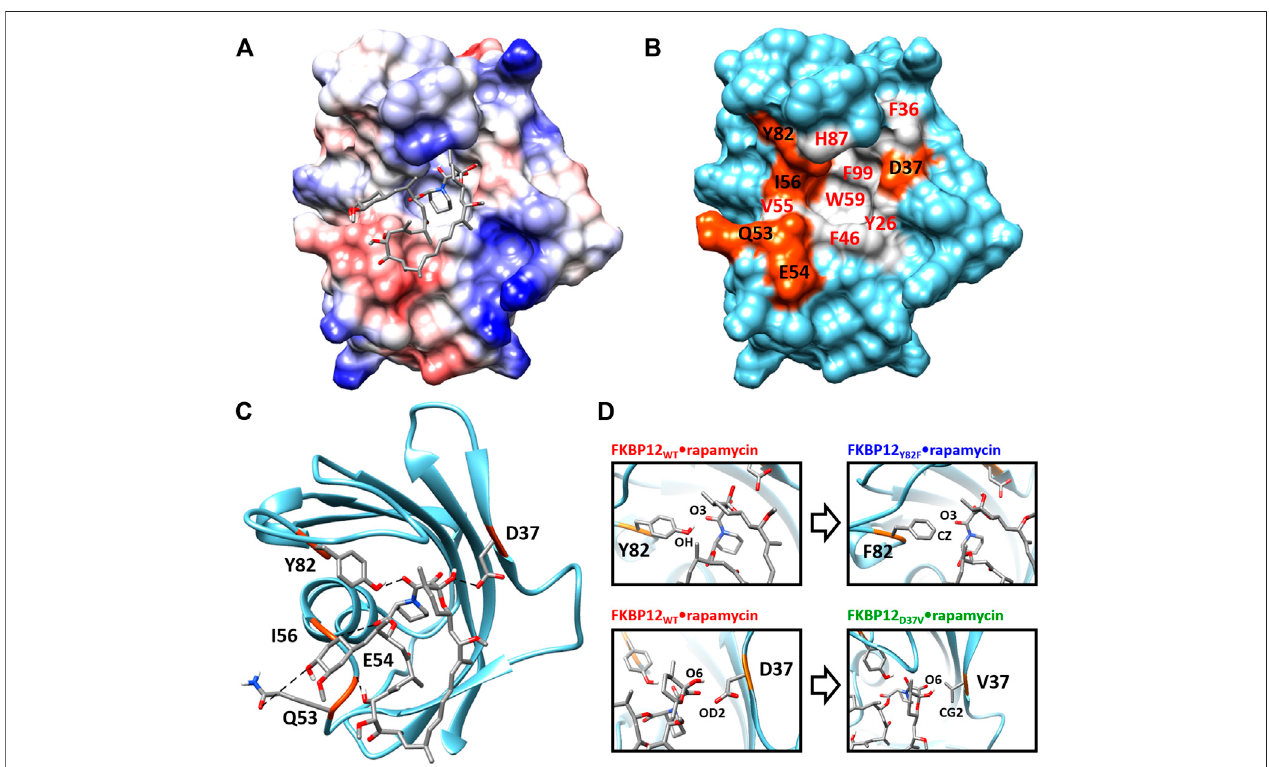
(cid:129) FIGURE 1 | Structure of the FKBP12 rapamycin complex as determined in PDB 1FKB. (A) Coulombic surface representation of the protein with the ligand as sticks. (B) Surface representation of the protein alone with the hydrogen-bond forming residues in orange and the hydrophobic residues in gray — coloring according to theLIGPLOTdiagramprovidedas SupplementaryFigureS1 (Wallaceetal.,1995). (C) Ribbonrepresentationoftheproteinwiththeligandassticks.The fi vehydrogen bonds formed between FKBP12 and rapamycin are shown as dashed lines. (D) Close-up view on the Y82 and D37 residues and resulting starting conformation obtained after either the Y82F or the D37V